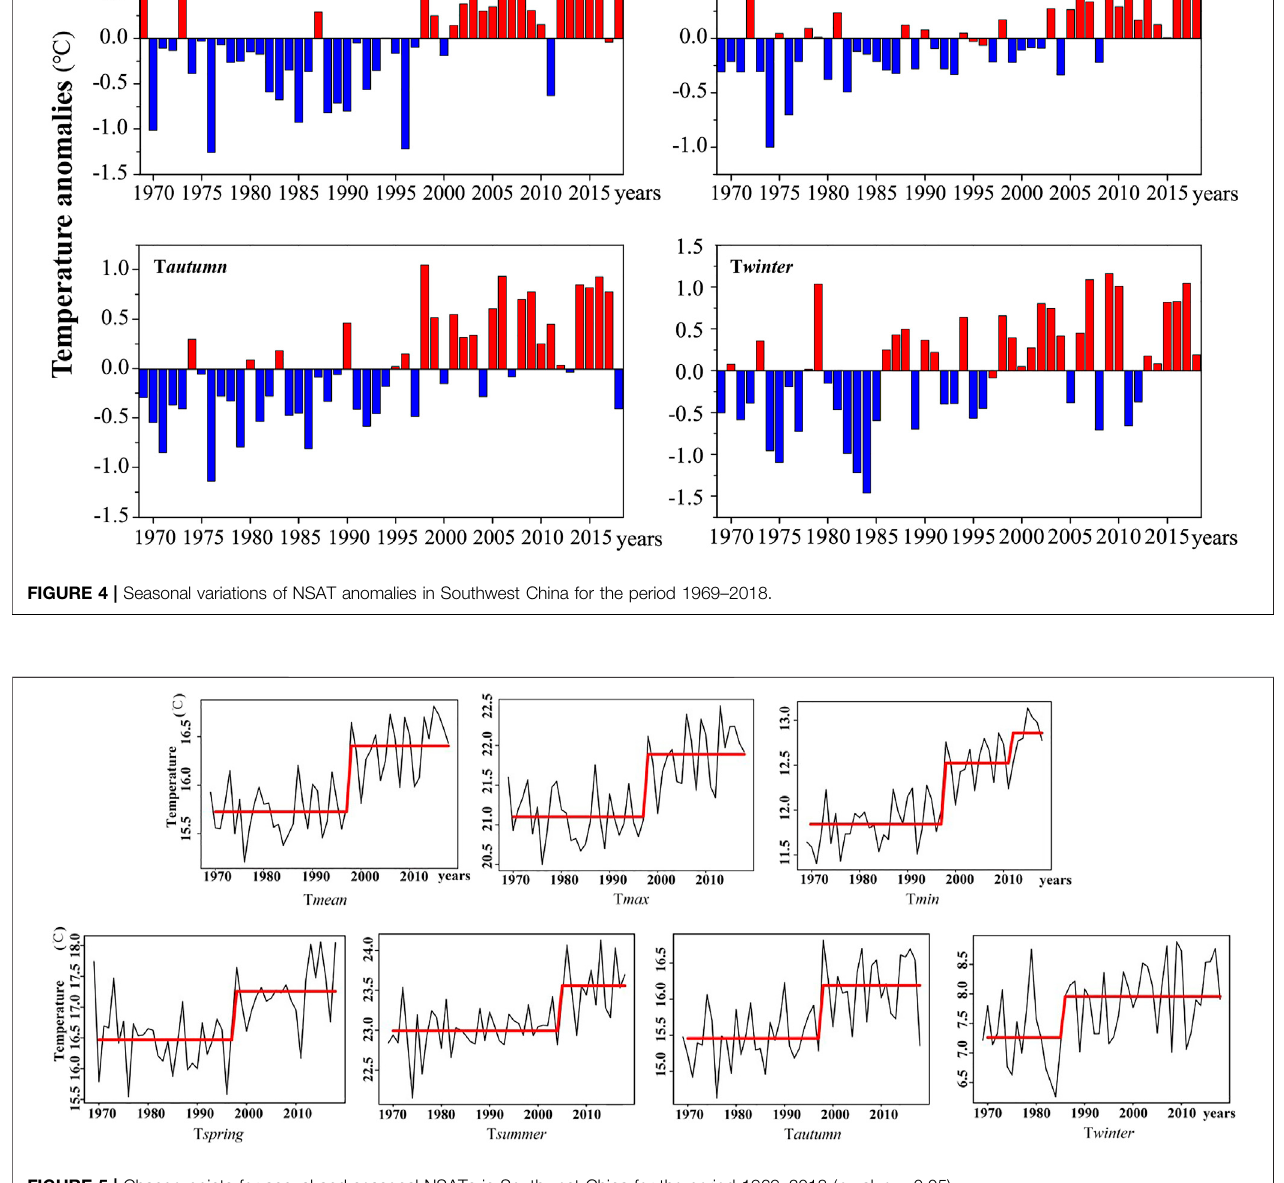
Frontiers in Earth Science |